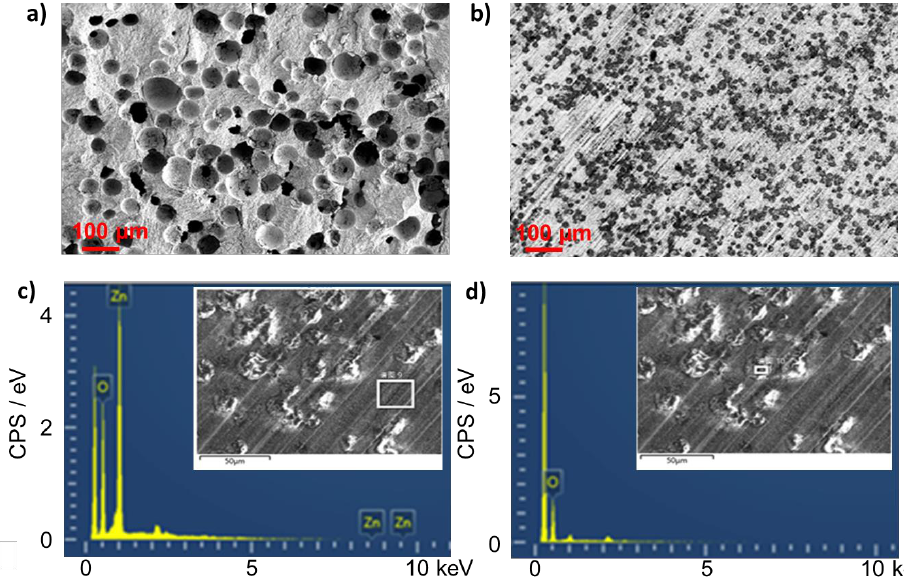
Figure 4. ( a ) The SEM image of the cross-section of the foam ceramic structure without impregnation, ( b ) BSD signal on SEM image of epoxy impregnated foam ceramic, ( c ) EDS of the ZnO area in the ceramic matrix, and ( d ) EDS of the epoxy-filled pore area.